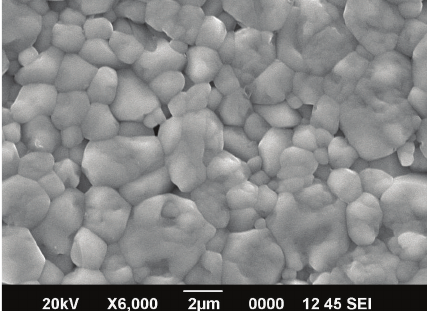
Figure 11: SEM image of sintered BaWO 4 pellet.